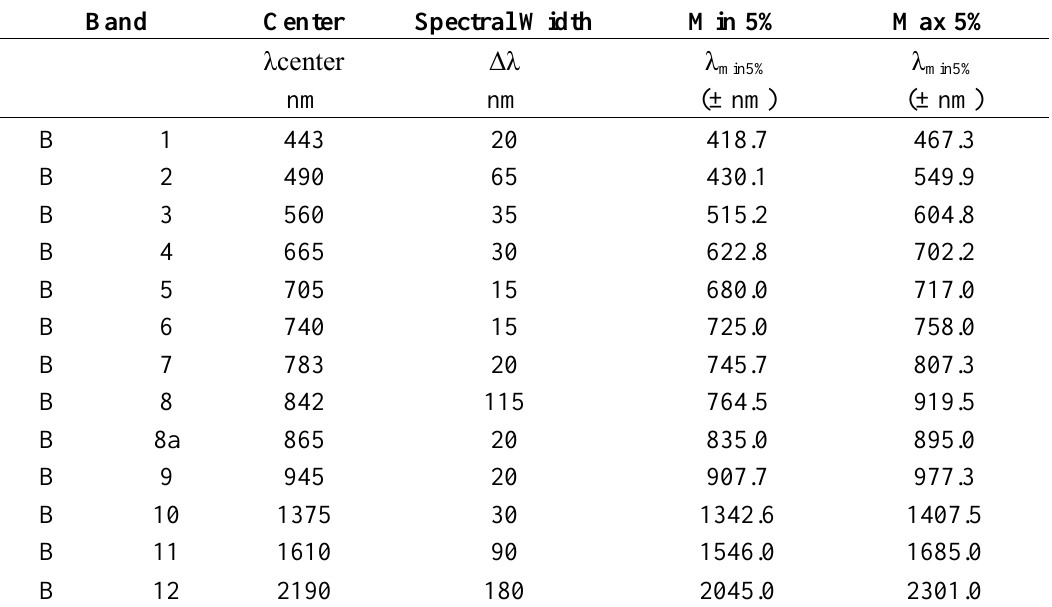
Table 1. Spectral characteristics of Sentinel-2 sensor